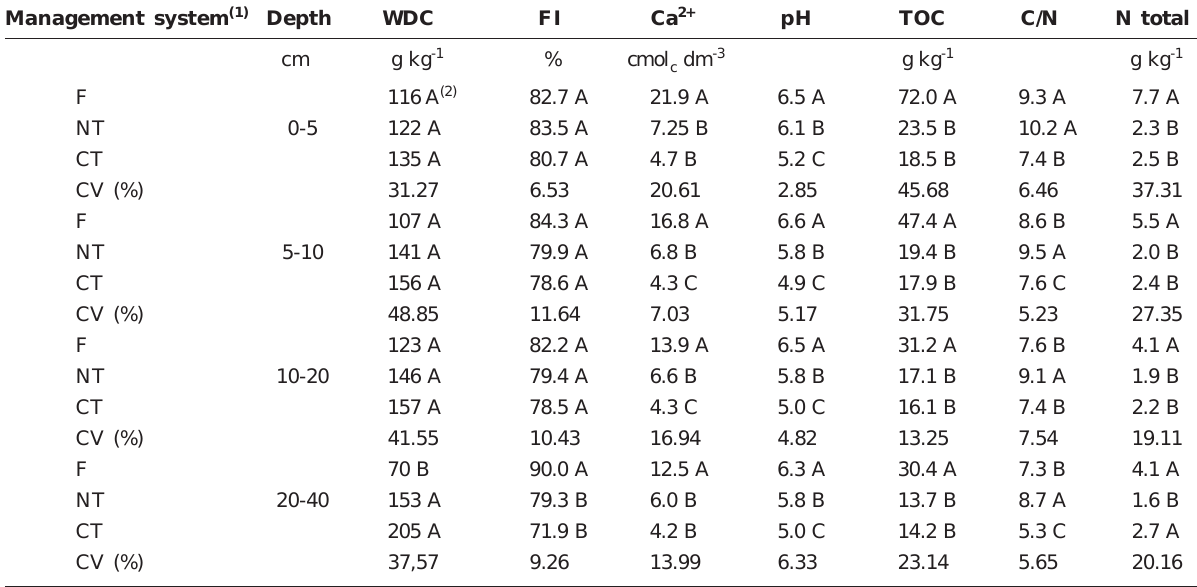
Table 4. Mean values for water-dispersed clay (WDC), clay flocculation index (FI), calcium (Ca 2+ ), pH, total organic C, C/N ratio and total N for different management